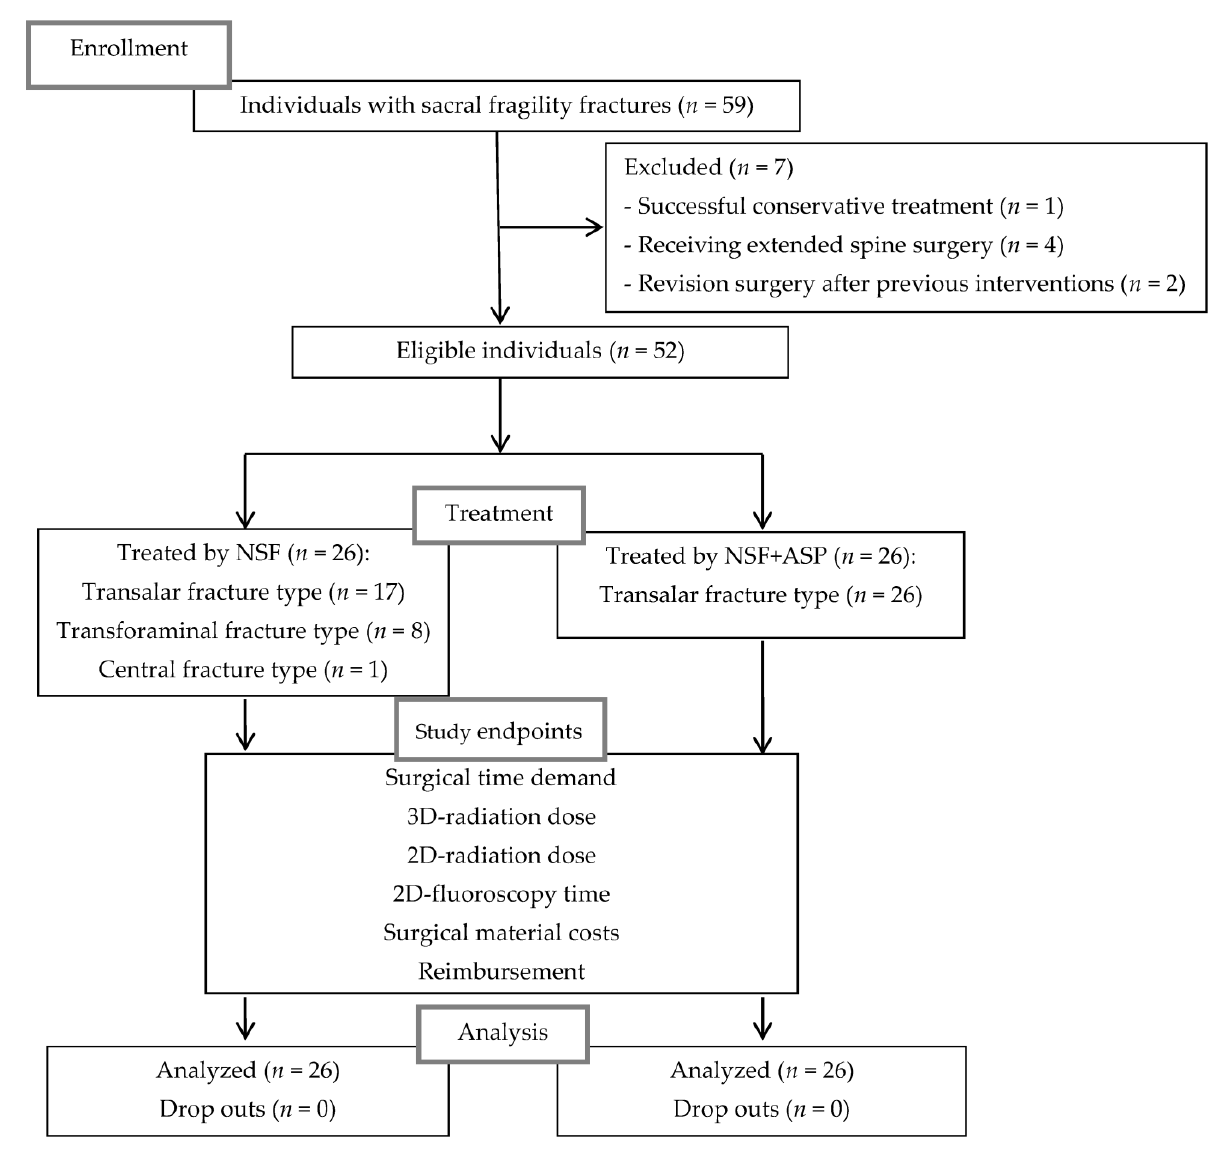
Figure 2. Flow diagram of the study. NSF indicates navigation-assisted screw fixation; ASP, additional sacroplasty.